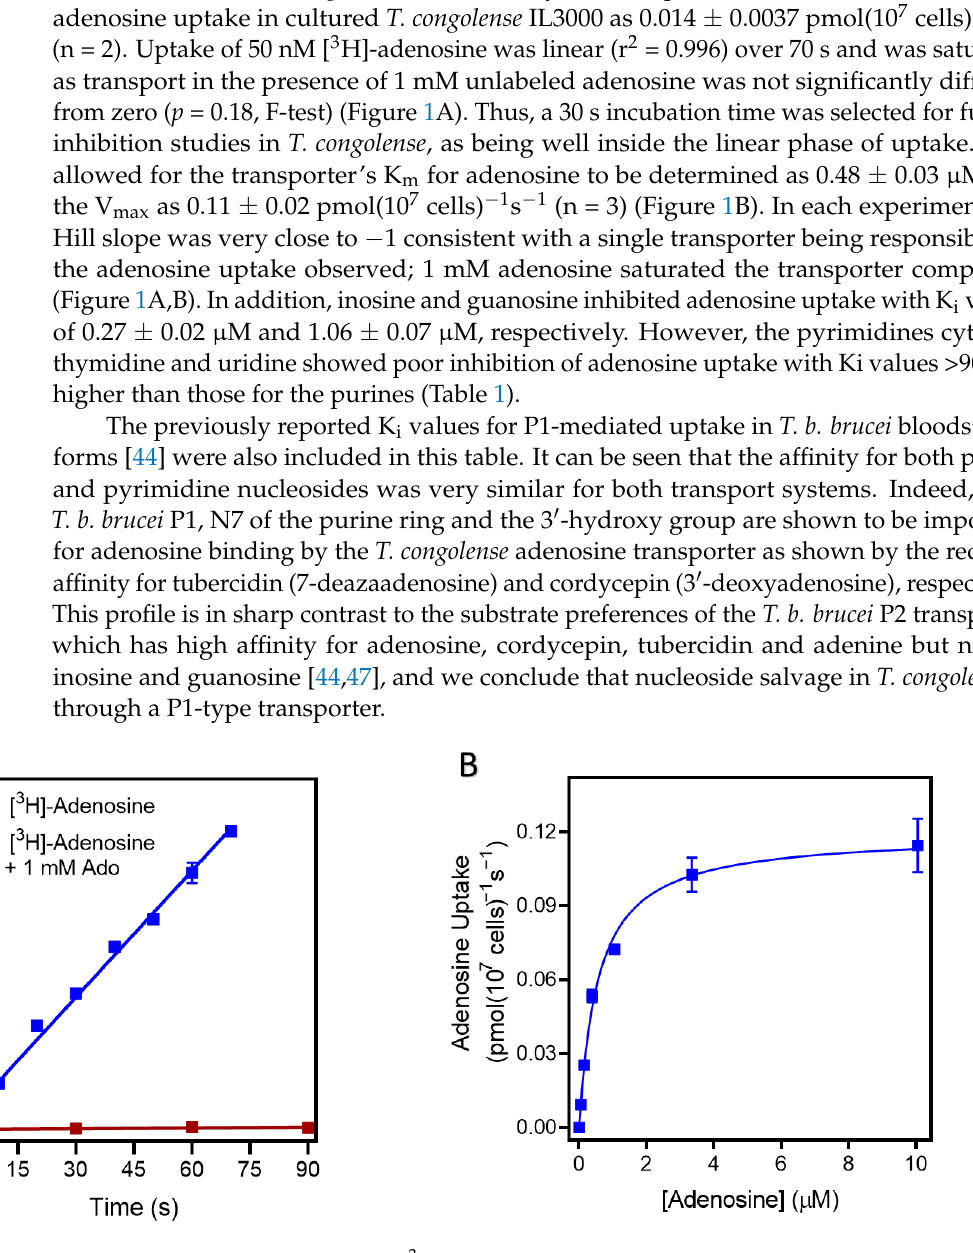
Figure 1. The uptake of 0.05 µ M [ 3 H]-adenosine in T. congolense IL3000. ( A ) Uptake over time, and ( B ) uptake at a fixed time point of 30 s, in the presence of unlabeled adenosine for the K m determination, using 0–1 mM adenosine in bloodstream forms of T. congolense . Graphs show one representative experiment out of two (panel A ) or three (panel B ) independent repeats, each carried out in triplicate. Error bars represent standard error of the mean (SEM). Table 1. K m and K i values for nucleosides on the transport of [ 3 H]-adenosine by T. congolense IL3000 and of T. b. brucei P1.